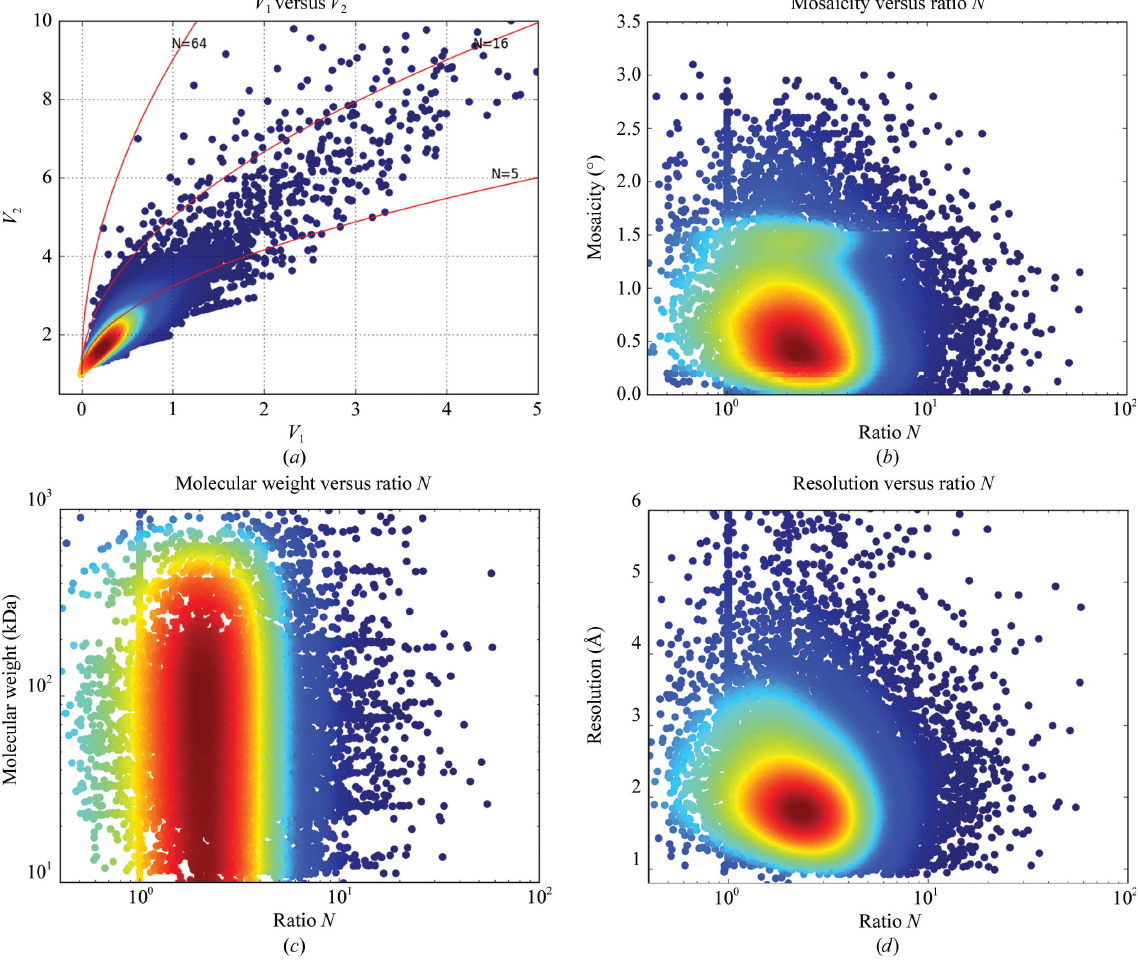
Figure 4 The variation of quality within crystals. ( a ) Comparison of variability measures of crystals. Values of V 1 and V 2 are plotted against each other and coloured by KDE. Lines show the values obtained for various ratios N between positions at increasing differences in diffraction power (for an explanation of the model, see Bowler & Bowler, 2014). The red line representing the ratio N = 5 is a reasonable cutoff between variable and homogenous diffraction within crystals. N = 15 864. ( b ) Mosaic spread values plotted against ratios N . Greater variability within a crystal is not related to higher mosaic spread values, Spearman R = (cid:4) 0.13, N = 13 780. ( c ) The molecular weight has no effect on the degree of variability, Spearman R = (cid:4) 0.06, N = 15 188. ( d ) Obtained resolution against ratios N . Higher variability is weakly correlated to higher resolution, Spearman R = (cid:4) 1.9, N = 15